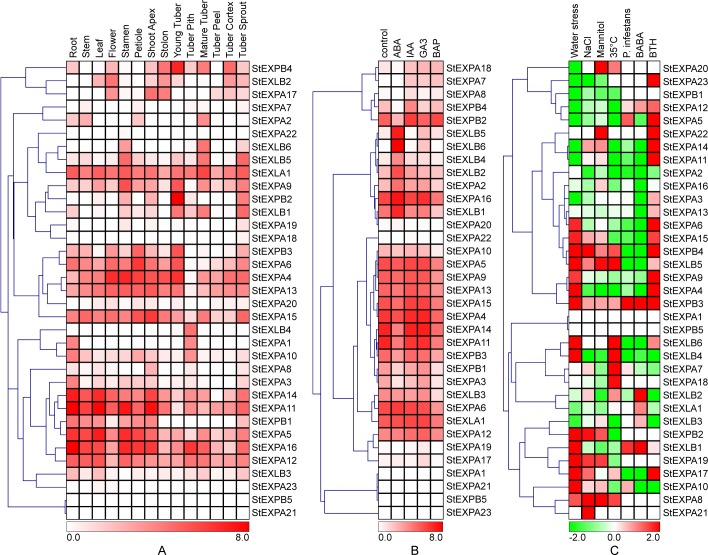
Expression profiles of potato expansin genes (StEXP).a, the expression patterns of StEXPs in the tissues of heterozygous diploid Solanum tuberosum, RH89-039-16. b, the expression patterns of StEXPs in doubled monoploid S. tuberosum Group Phureja clone, DM1-3. The whole plant in vitro was respectively treated for 24 hours by 50 μmol L-1 ABA, 10 μmol L-1 IAA, 50 μmol L-1 GA3, and 10 μmol L-1 BAP. c. the expression patterns of StEXPs in DM1-3. The whole plant in vitro was exposured to 150 mmol L-1 NaCl, 260 μmol L-1 Mannitol, 35°C high temperature, respectively, or three separate detached leaves of the plant was spray inoculated by Phytophthora infestans, BABA and BTH, respectively [33]. All FPKM = 0 of transcripts were replaced by FPKM = 0.01, and the FPKM data in Fig 4A and 4B was undergone a log2 (FPKMTreatment / FPKMControl) transformation.